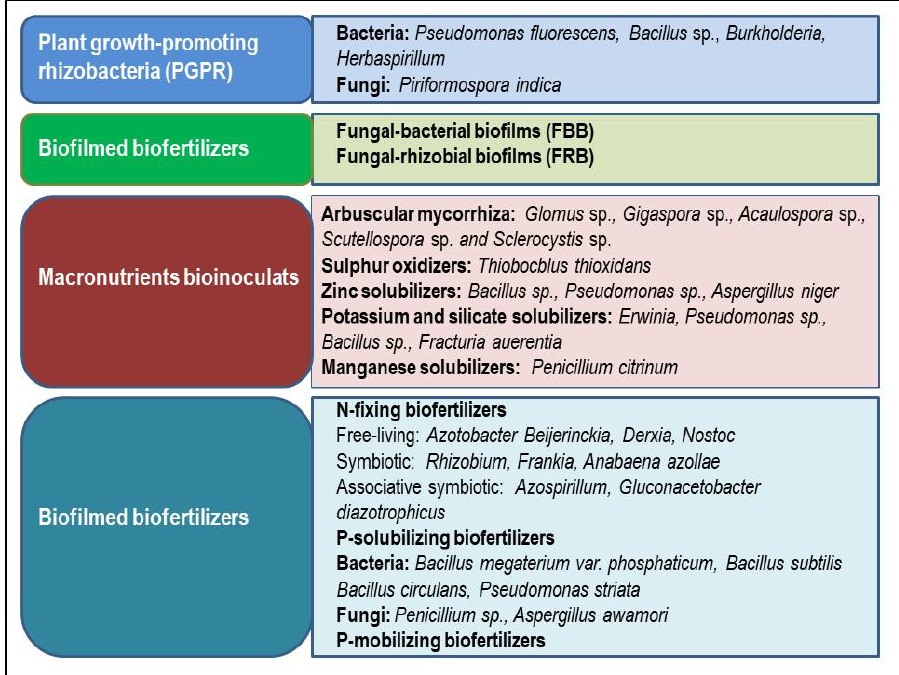
Figure 2. Prospective bioinoculants which may be used in green agriculture.